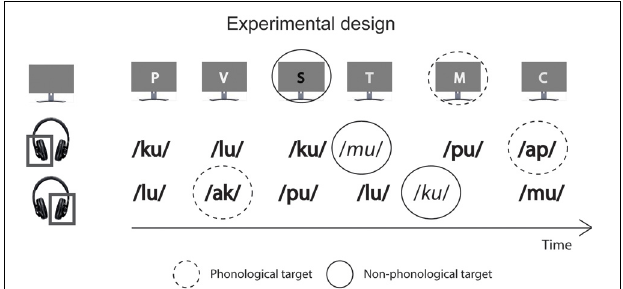
FIGURE 1 | A schematic illustration of experimental conditions. In all conditions, the participants were presented with spoken syllables and written letters. They were instructed to selectively attend to syllables delivered to the left ear, to syllables delivered to the right ear, or to the written letters and to perform a phonological or non-phonological task involving the attended stimuli. Most syllables were spoken by one of the four male voices (syllables printed in bold) and started with a consonant. In the left-ear and right-ear phonological tasks (L P and R P , respectively), targets were infrequent attended-ear syllables starting with a vowel (marked with a dashed circle), and in the left-ear and right-ear non-phonological tasks (L NP and R NP , respectively), targets were infrequent syllables spoken by one of the four female voices (syllables printed in italic and marked with a continuous circle). Most visually presented consonant letters had a name starting with a consonant (e.g., the English name of the letter T is pronounced like “tea” and thus starts with a consonant) and were written in one of four fonts lighter than the gray background on the screen. In the visual phonological and non-phonological tasks (V P and V NP , respectively), targets were infrequent letters with their name beginning with a vowel (marked with a dashed circle; e.g., the English name of letter R is pronounced like “are” and thus starts with a vowel) or infrequent letters written in one of four fonts that were darker than the background (marked with a continuous circle).